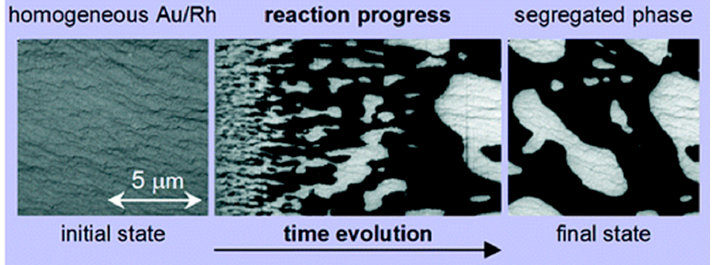
Figure 10. LEEM imaging of the formation of a segregated phase due to the gold mass transport observed under reaction conditions. Reprinted with permission from [182]. Copyright 2005, American Chemical Society.